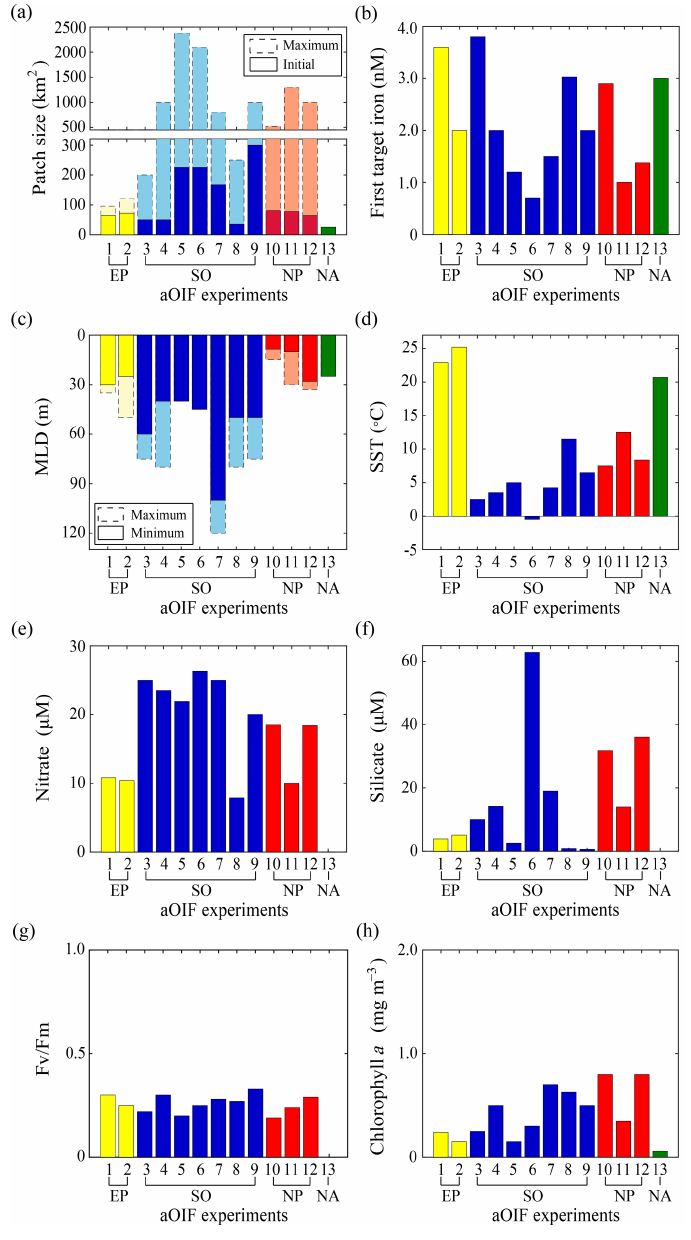
Figure 6. (a) Maximum (bar with dotted line) and initial (bar with solid line) patch size (km 2 ) during artificial ocean iron fertilization (aOIF) experiments. (b) First target iron concentrations (nM). (c) Maximum (bar with dotted line) and minimum (bar with solid line) mixed layer depth (MLD, m) during aOIF experiments. (d) Initial sea surface temperature (SST, ◦ C). (e) Initial nitrate concentrations (µM). (f) Initial silicate concentrations (µM). (g) Initial F v /F m ratios. (h) Initial chlorophyll a concentrations (mgm − 3 ). Note that the numbers on the x axis indicate the order of aOIF experiments as given in Fig. 4 and Table 1 and are grouped according to ocean basins: equatorial Pacific (EP) (yellow bar), Southern Ocean (SO) (blue bar), subarctic North Pacific (NP) (red bar), and subtropical North Atlantic (NA) (green bar). Sources are Kolber et al. (1994), Martin et al. (1994), Behrenfeld et al. (1996), Coale et al. (1996, 1998, 2004), Steinberg et al. (1998), Boyd et al. (2000, 2005, 2007), Boyd and Law (2001), Gall et al. (2001a), Gervais et al. (2002), Law et al. (2003, 2006, 2011), Tsuda et al. (2003, 2005, 2007), Turner et al. (2004), Bakker et al. (2005), Bozec et al. (2005), de Baar et al. (2005), Hiscock and Millero (2005), Takeda and Tsuda (2005), Tsumune et al. (2005, 2009), Marchetti et al. (2006a), Rees et al. (2007), Suzuki et al. (2009), Harvey et al. (2010), Smetacek and Naqvi (2010), Berg et al. (2011), Hadfield (2011), Peloquin et al. (2011b), Smetacek et al. (2012), Thiele et al. (2012), Martin et al. (2013), Ebersbach et al. (2014), and Latasa et al.